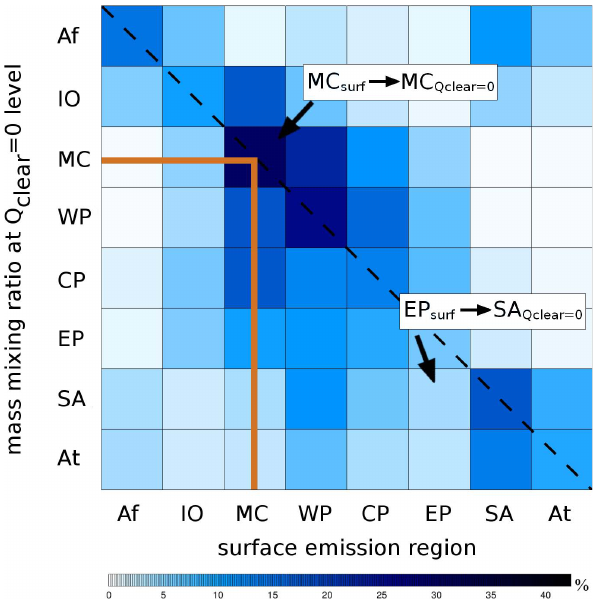
Fig. 3. A “surface-TTL” matrix where the boxes represent tropical transport of 8 surface emitted tracers (x-axis) to the same 8 regions (y-axis) at the Q clear =0 level – here shown for the November in- tegration. The relative mean mass mixing ratio (see Fig. 2) in each box is represented by colour intensity in accordance to the range shown by the colour-scale below the matrix. The dotted black line illustrates the boxes where high concentrations would indicate ef- ficient vertical transport of the tracers from their surface regions to the Q clear =0